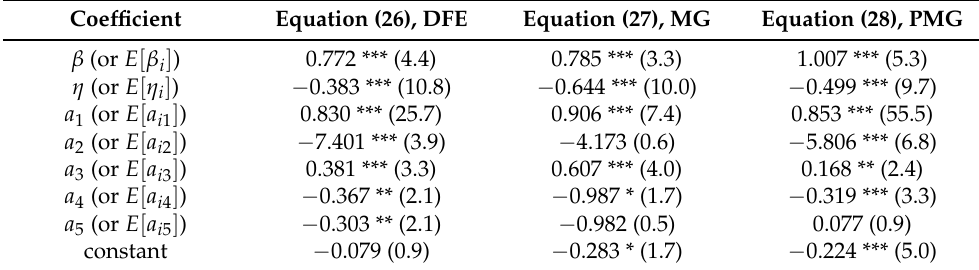
Table 3. Non-stationary Heterogeneous Panel Model, Decomposed UCC,